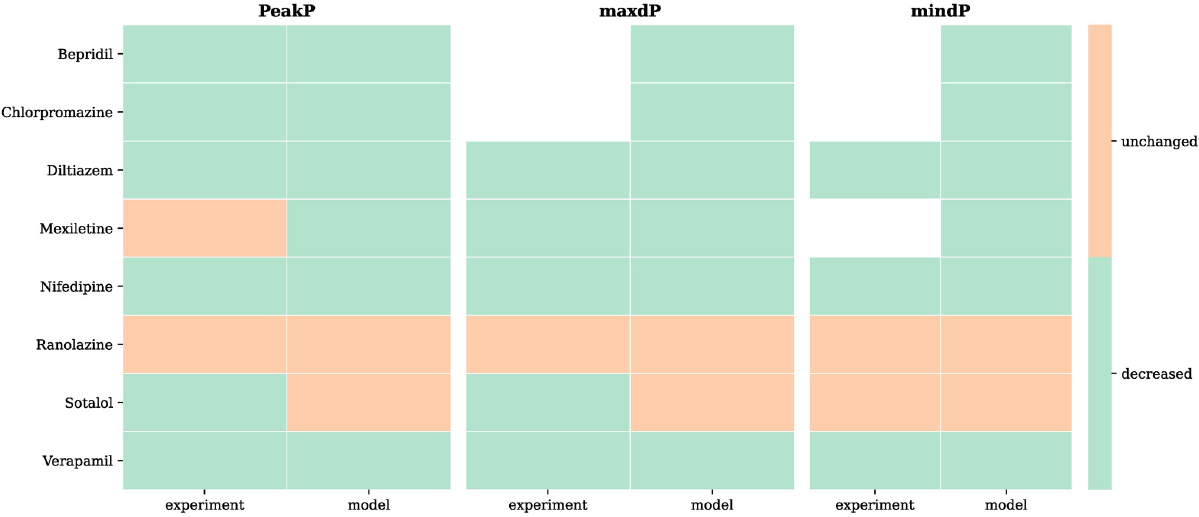
Fig 4. Model validation against known CiPA compounds effects on whole-organ function. Eight CiPA compounds effects (“experiment” columns) on PeakP, maxdP and mindP are compared with model same compounds’ predicted effects on the same features (“model” columns). The effects of compounds are colour-coded as orange (feature unchanged) and green (feature decreased). None of the compounds caused an increase in the considered LV features. White/empty space means that the specific effect could not be retrieved from the examined literature studies. Model predicted effects are in agreement with the experimentally observed effects for 6 out of 8